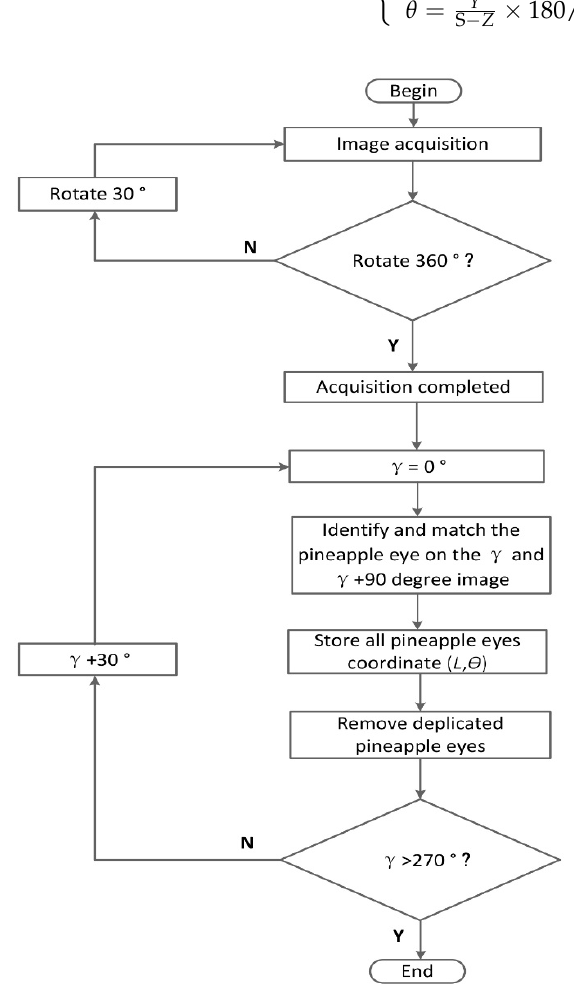
Figure 9. Flow diagram of the 3D positioning method for pineapple eyes.